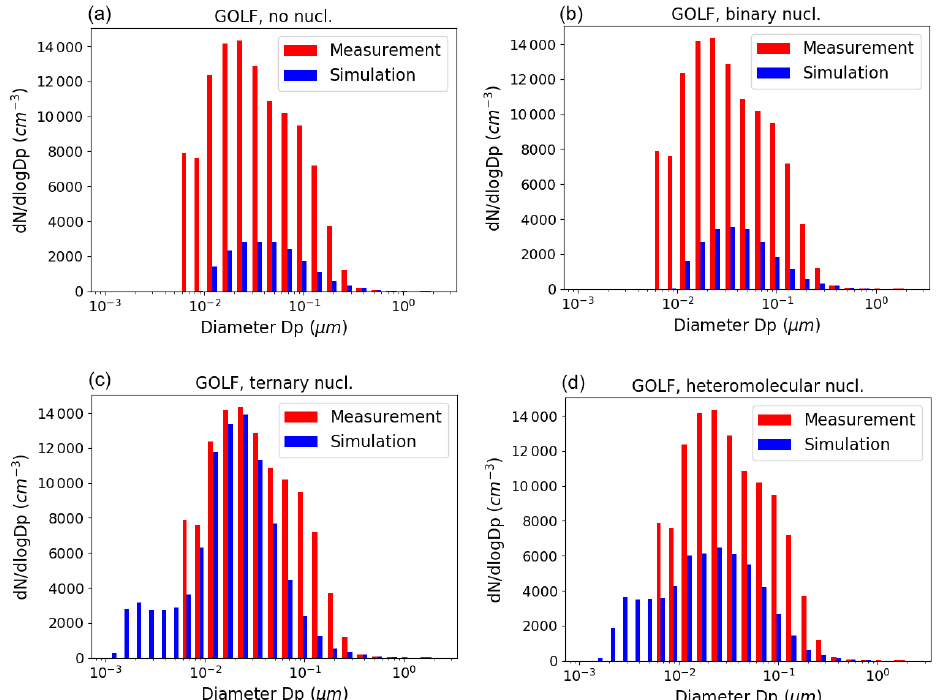
Figure 9. Size distribution of the number concentrations (in cm − 3 ) at the GOLF site for the simulation without nucleation (a) , with binary nucleation (b) , with ternary nucleation (c) , and with heteromolecular nucleation (d)